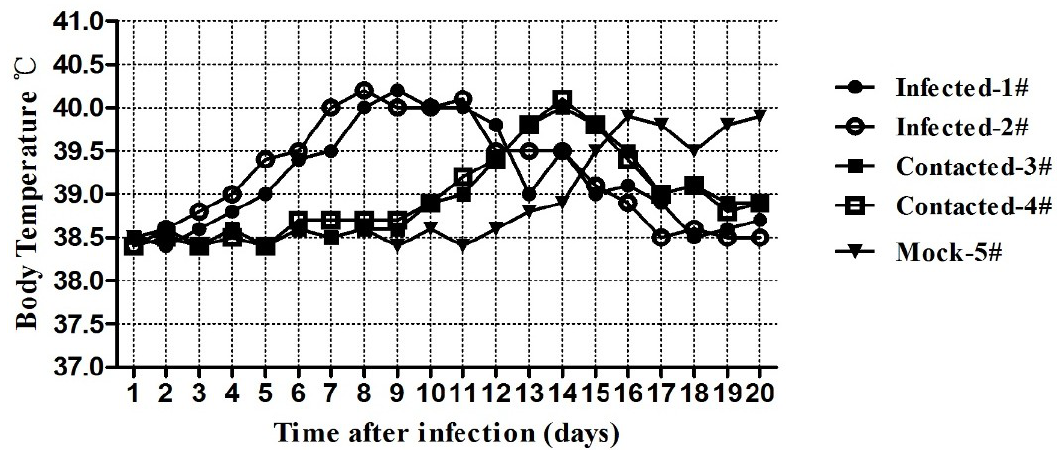
Figure 6. Temperature changes of cats infected with FHV-1.